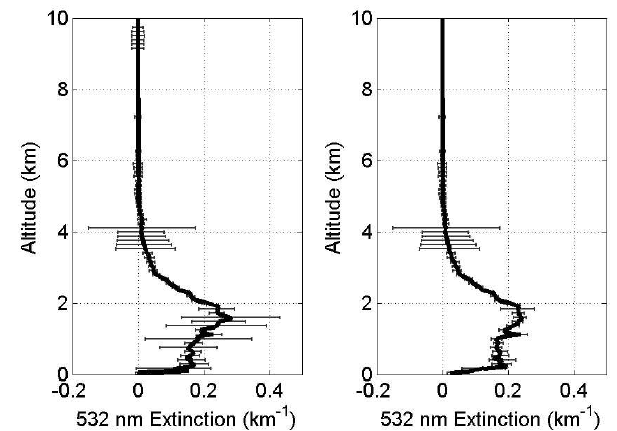
Fig. 2. Average 532nm extinction profiles (day and night com- bined), August 2007, 35–39 ◦ N, 75–80 ◦ W. Left panel: unscreened cloud-free profile; Right panel: after screening